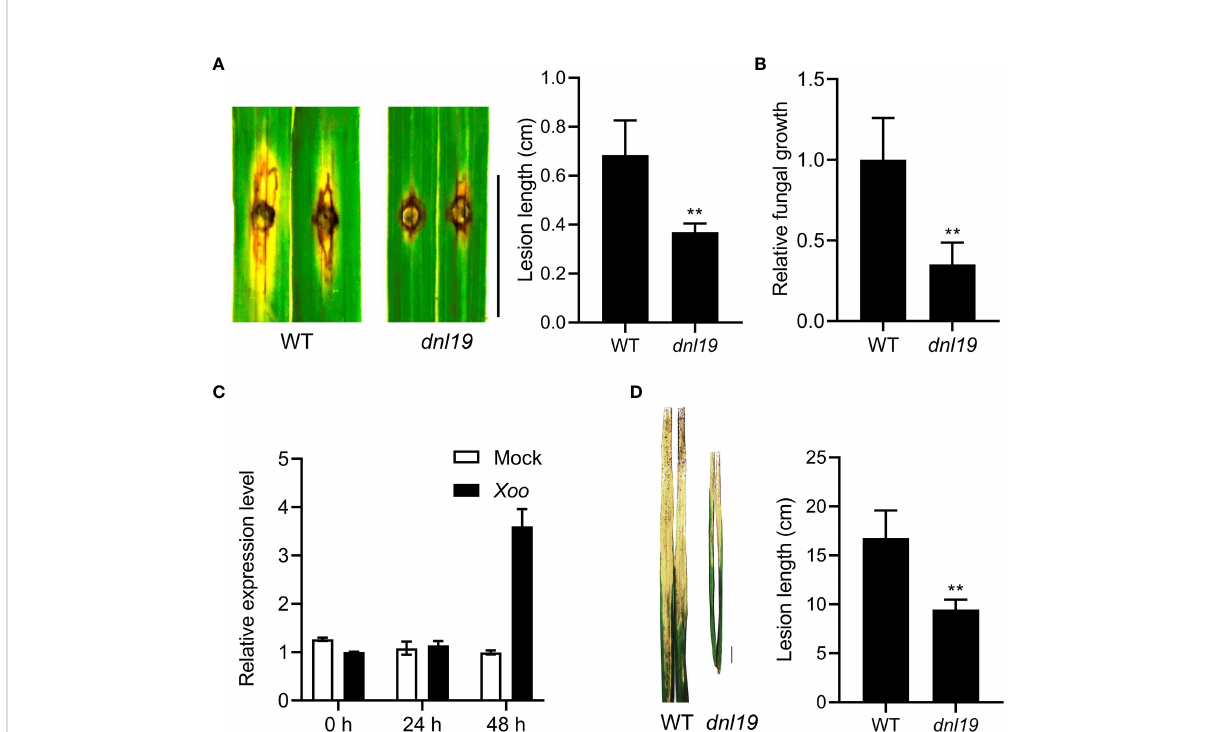
FIGURE 5 Phenotypical characterization of dnl19 and wild type against M. oryzae and Xoo . (A) The dnl19 mutant was inoculated with the M. oryzae isolate. Blast resistance was evaluated by punch inoculation. Lesion length were determined on leaves at 7 days after inoculation. Bar = 1 cm. Data are means ± SD ( n =6, ** P < 0.01, Student ’ s t -test). (B) Fungal growth was quanti fi ed by qPCR. Data are means ± SD ( n =6, ** P < 0.01, Student ’ s t - test). (C) The change of relative expression level of OsCSLD4 in response to Xoo strain PXO99 treatment. The leaves of Nipponbare plants at tillering stage were used for inoculation. The expression of OsActin1 was used as an internal control. (D) Phenotypes of disease reactions in dnl19 fl ag leaves after inoculation with Xoo strain PXO99. Bar = 1 cm. Disease lesion length of wild type and mutant was measured at 2 weeks after inoculation. Data are means ± SD ( n ≥ 10, ** P < 0.01, Student ’ s t